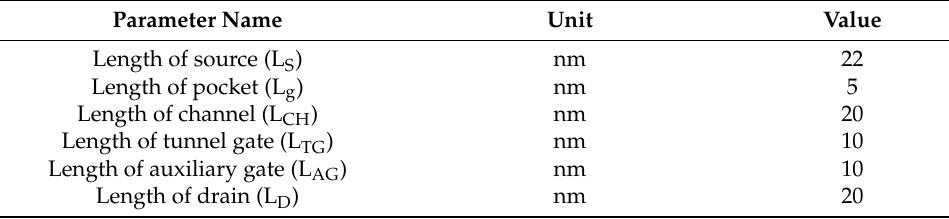
Table 1. The fundamental geometrical and physical parameters of the